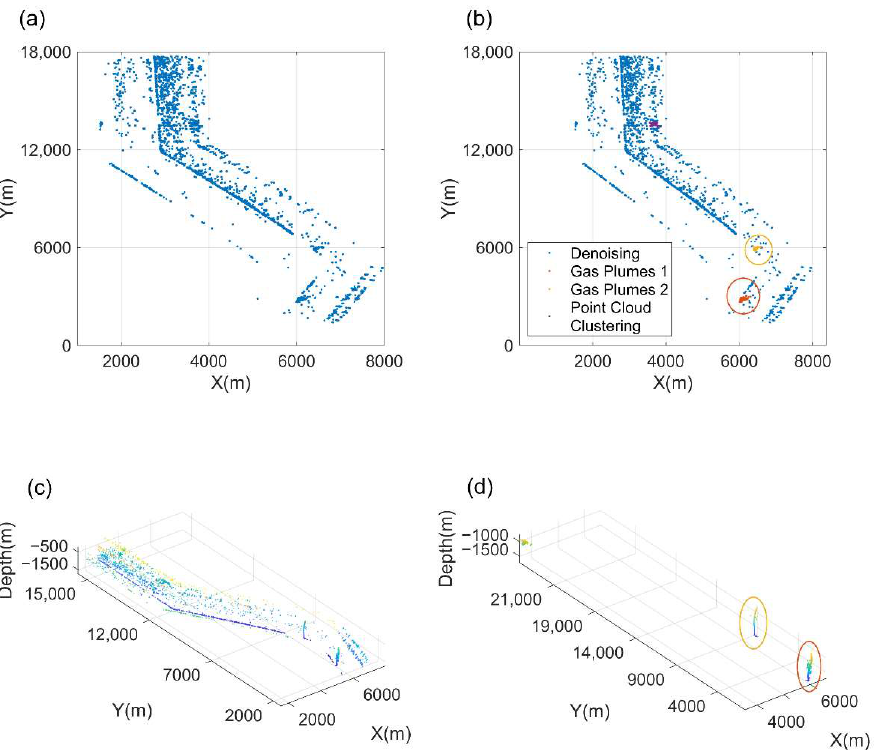
Figure 8. Comparison of the DBSCAN calculation results. ( a ) shows the 2D image of the original point cloud mapped to the XOY domain, and ( b ) shows the 2D image results of the point cloud mapped to the XOY domain after calculation, with the large blue dots being the identified noise points in the MWC, and the detection of three high-density regions clustered with different color markings; ( c ) shows the original spatial point cloud, and ( d ) shows the point cloud results after calculation, in which the identified noisy points are removed, and it can be seen that only three high-density, small-area candidate point cloud clusters remain in the MWC after denoising, and they are extracted and stored separately as candidate target point clouds for the next step of target detection.